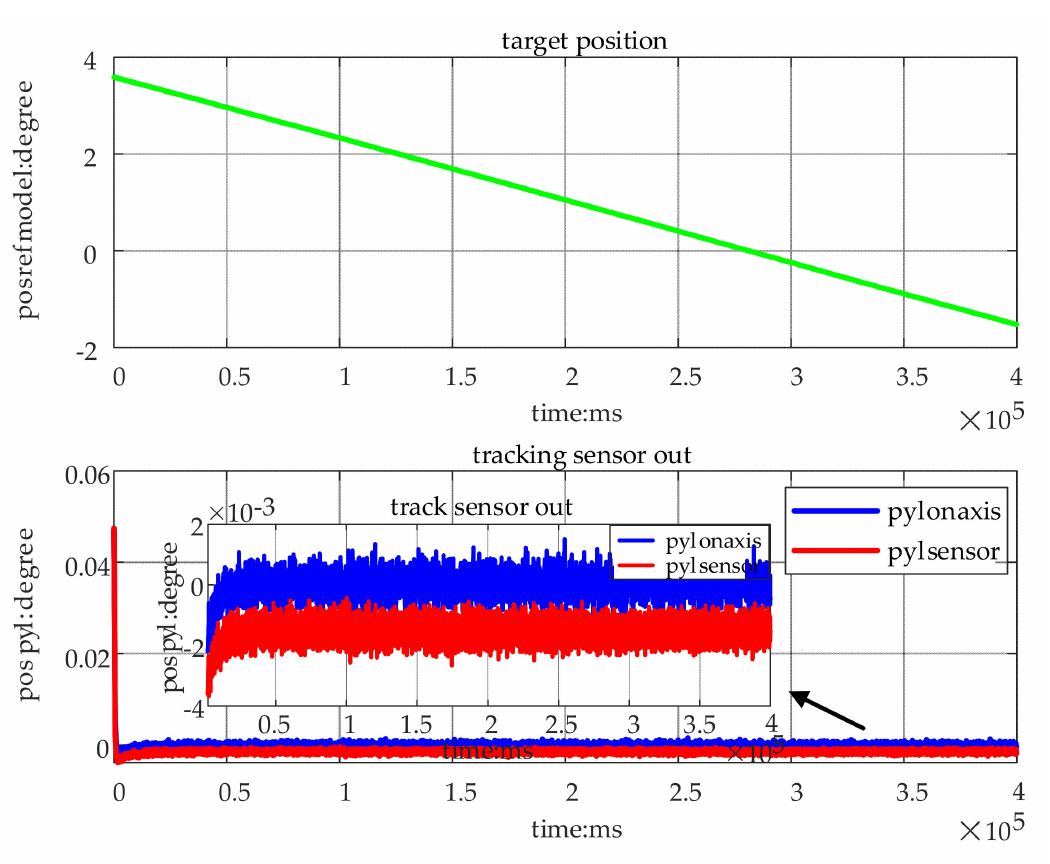
Figure 11. Offset curve of sun